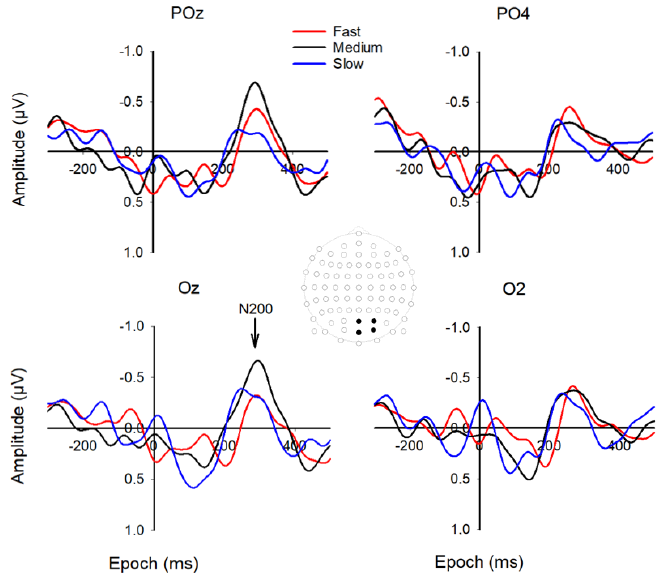
Figure 5. Grand-averaged waveforms of the VEP’s. Epoch is from − 300 to 500 ms. The head drawing (nose up) shows scalp locations of the 81 standard channels with the occipitoparietal channels of interest depicted with filled black circles (from top to bottom and left to right): POz, PO4, Oz, and O2. The arrow shows the N2 component of the three speeds at approximately 275 ms. Three grand averaged channels were selected for MRP analysis, based on the highest mean P300 amplitude, i.e., FCz, FC2, and Cz (see Figure 6). The average mean MRP P3 latency was 295 ms (SD = 87) for slow, 284 ms (SD = 81) for medium, and 297 ms (SD = 107) for fast speed.